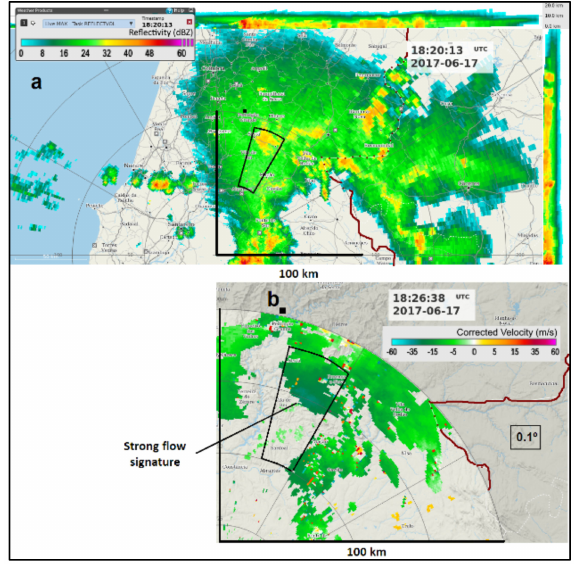
Figure 7. ( a ) MAXZ at 18:20 UTC, 17 June 2017, C/CL radar. Range rings are marked every 50 km. Segments mark the 100-km range. Fire areas are represented by a black square symbol. An azimuthal sector (50–80-km range) in the north–eastern quadrant where modest reflectivity cores were observed is also defined. Around the upper and right borders of the central image, the side panels of MAXZ are represented. ( b ) Zoomed-in area from ( a ) extracted from the Doppler scan, storm-relative velocity PPI, 0.1 ◦ tilt at 18:26 UTC, 17 June 2017. Strong flow signature in a much larger scale than that of single discrete downbursts is marked. Border with Spain is represented by the brown